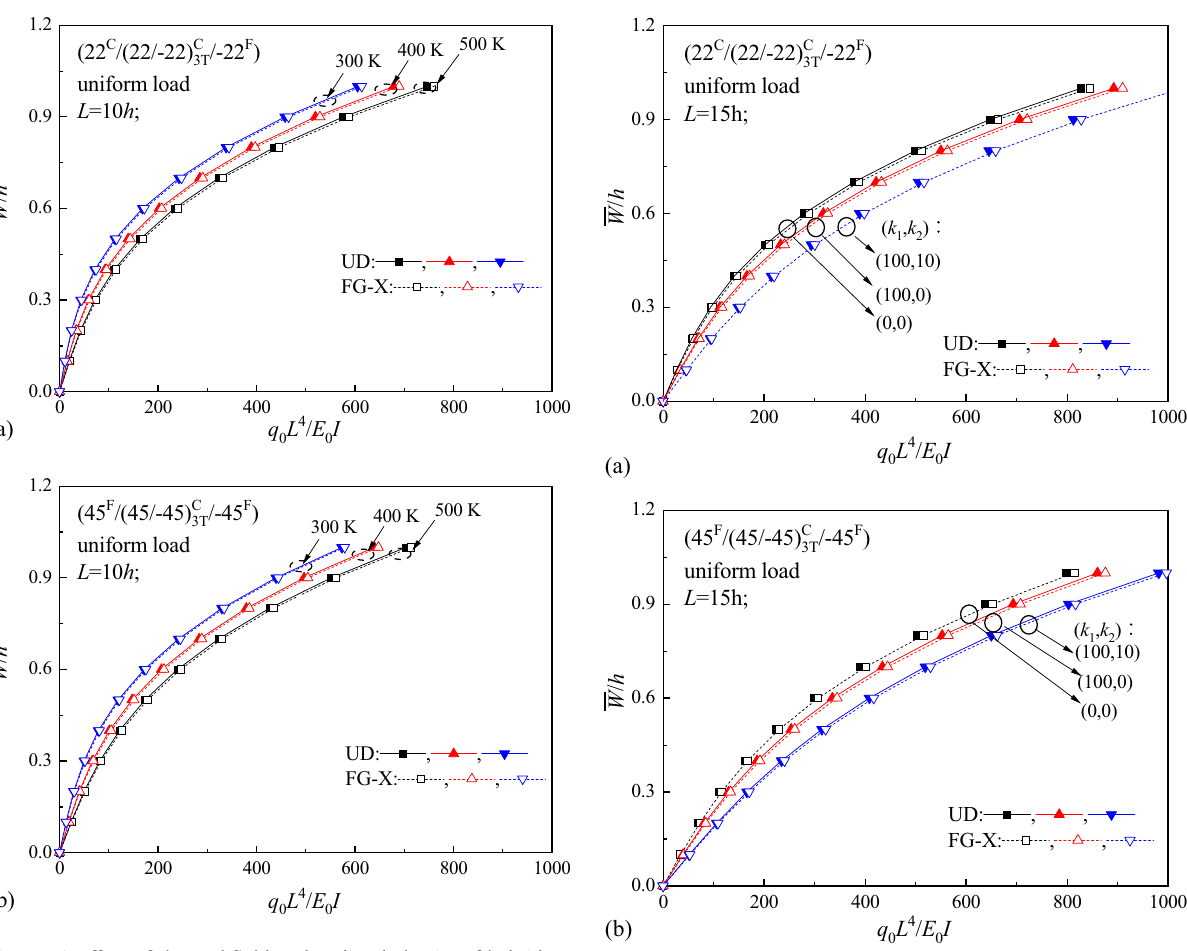
Figure 16: E ff ect of thermal fi eld on bending behavior of hybrid laminated plates. Figure 17: E ff ect of foundation coe ffi cient on bending behavior of hybrid laminated